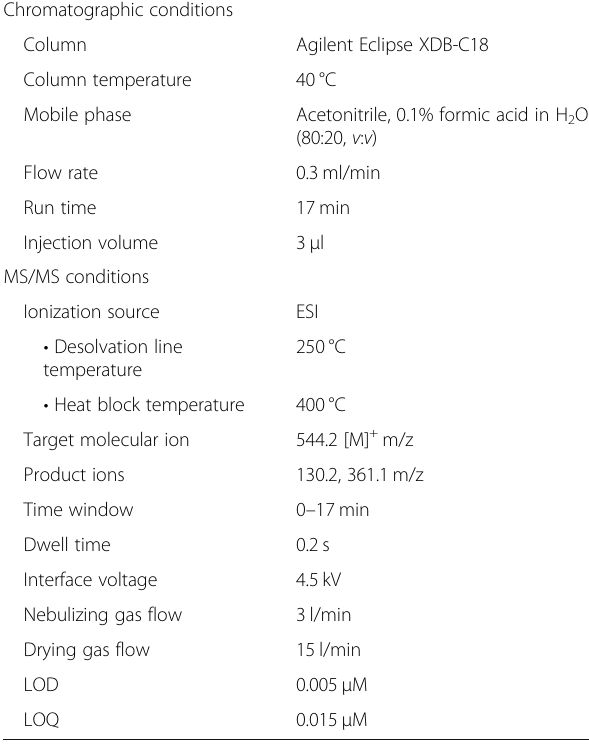
Table 1 HPLC-ESI-MS/MS conditions for analysis of Dox Chromatographic